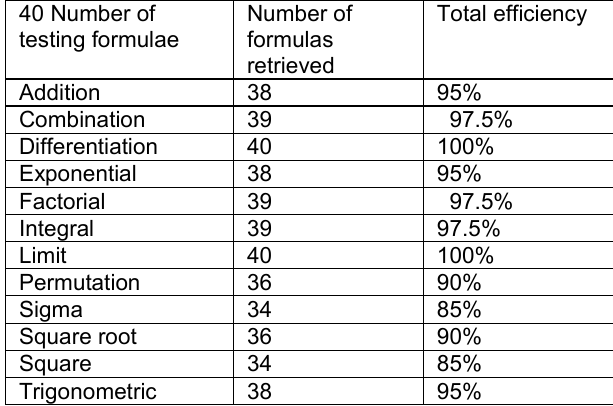
Figure 2. Training model and testing with text file